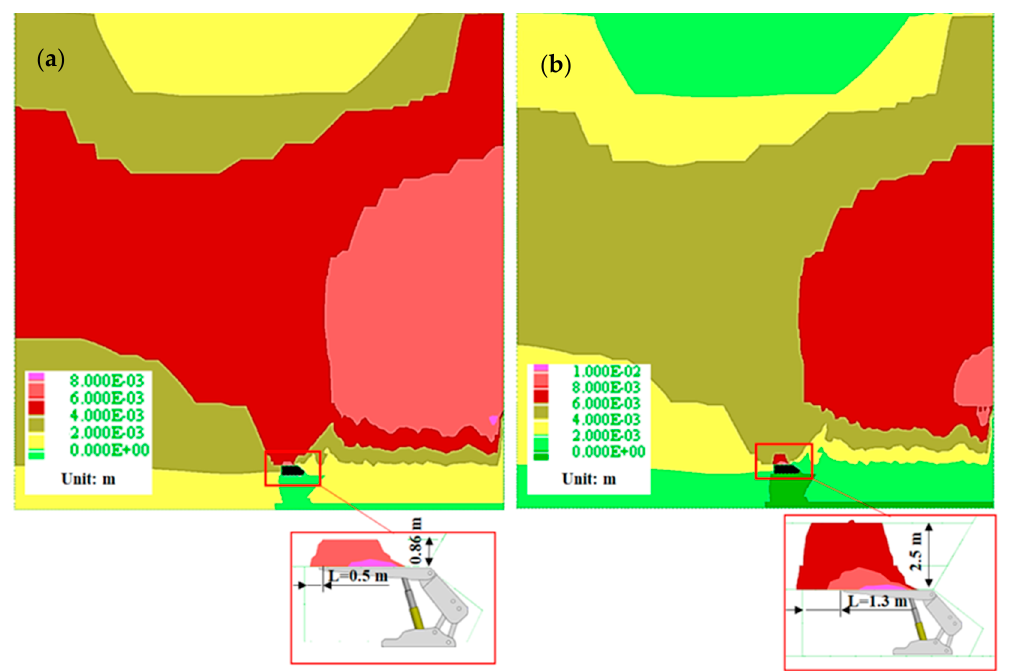
Figure 15. Vertical displacements in the rock mass model for the considered variant III, where: ( a ) before the web cut, ( b ) after the web cut.